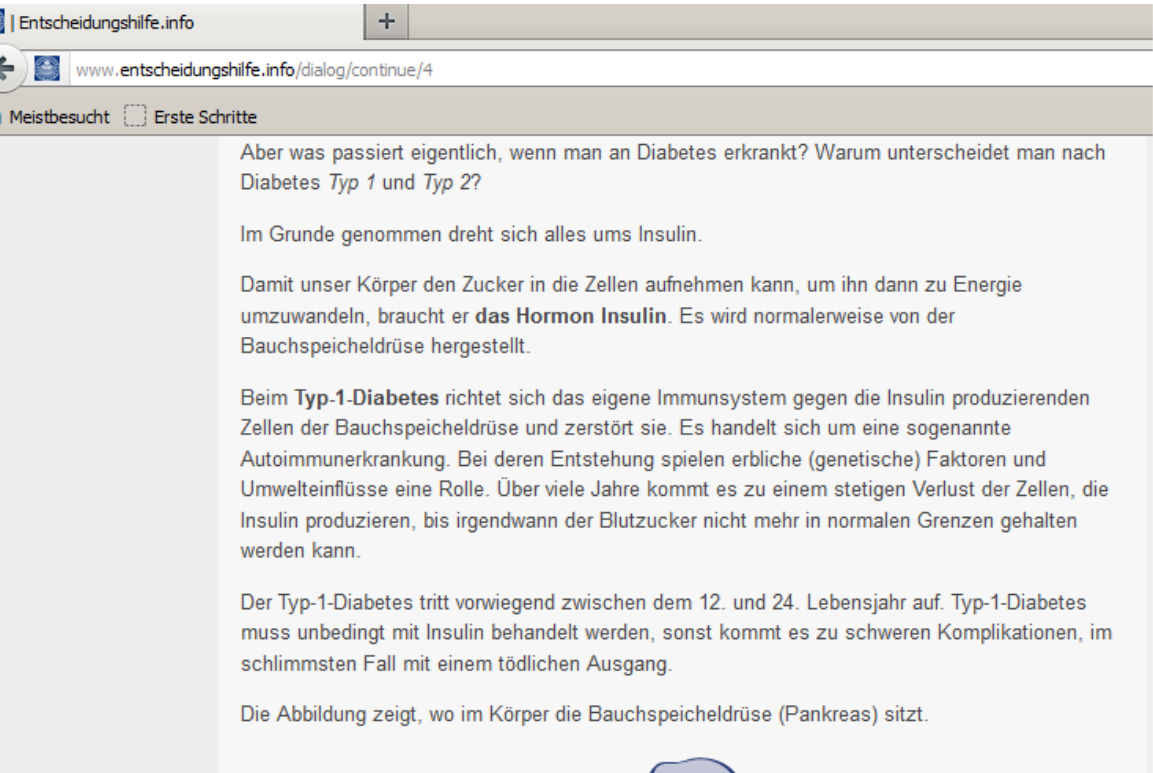
Figure 1. Dialogue